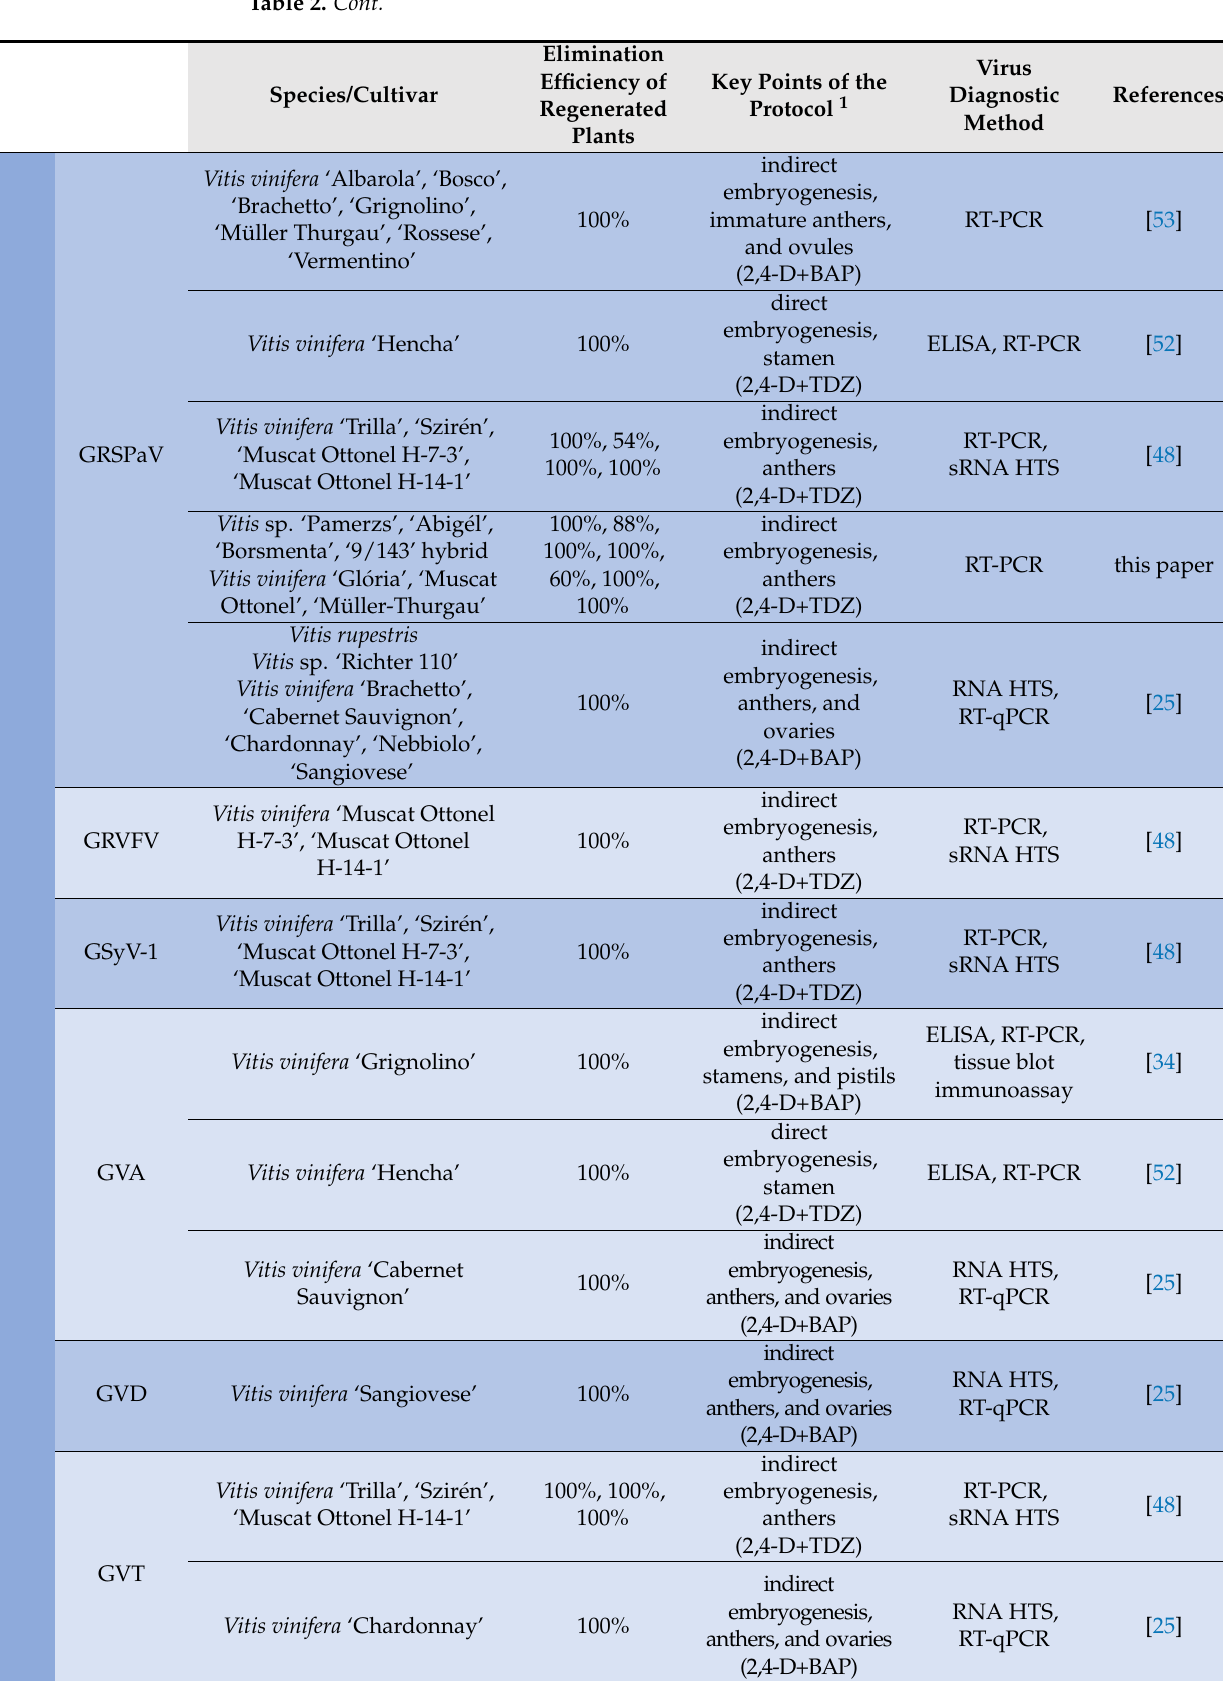
Table 2. Cont. Species/Cultivar